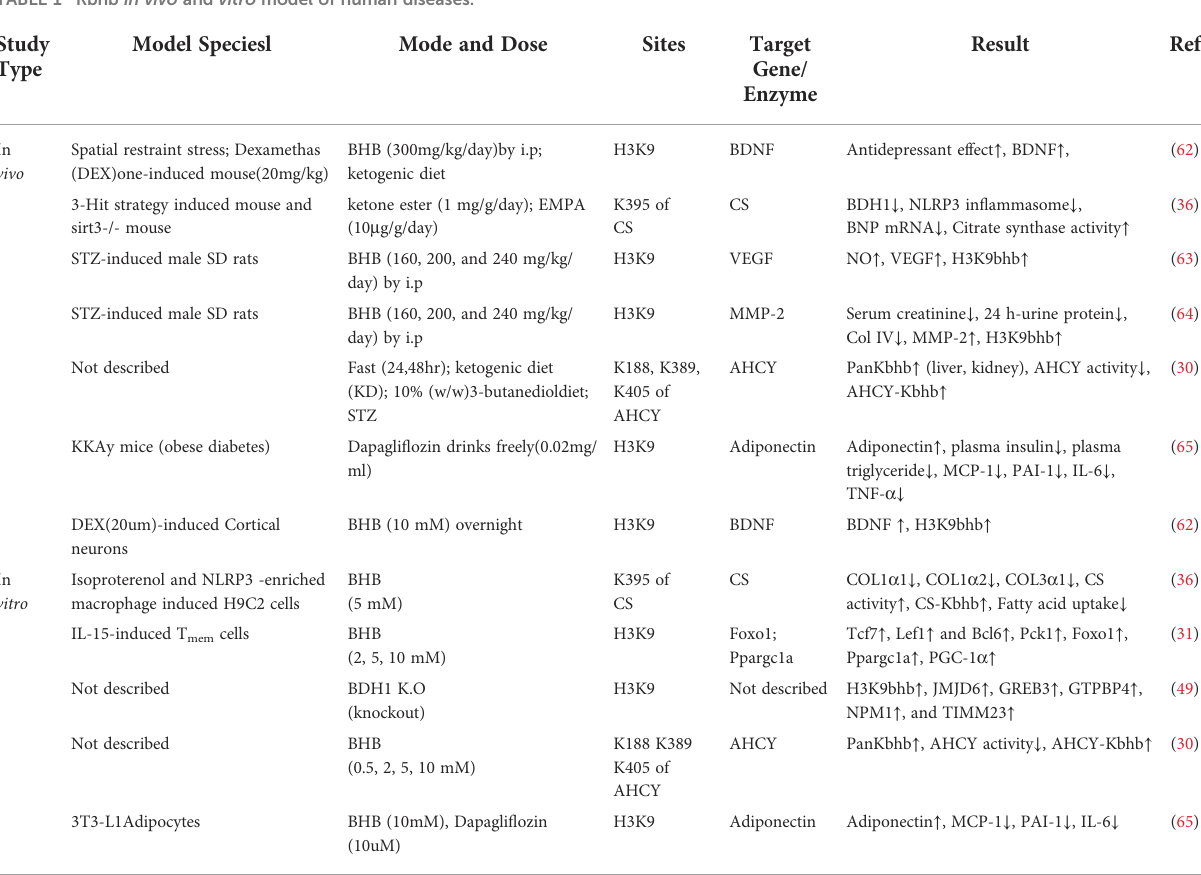
TABLE 1 Kbhb in vivo and vitro model of human diseases. Study